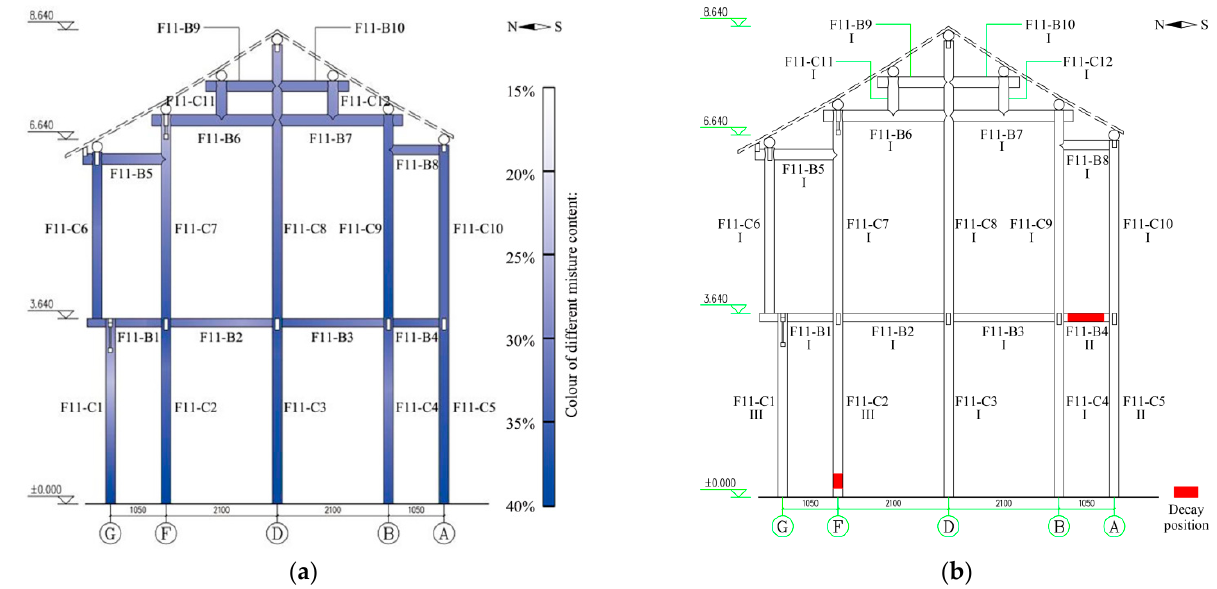
Figure 22. Moisture content and decay of F11 in Fujiu Zhou house; ( a ) schematic diagram of moisture content; ( b ) schematic diagram of decay position and decay grade.